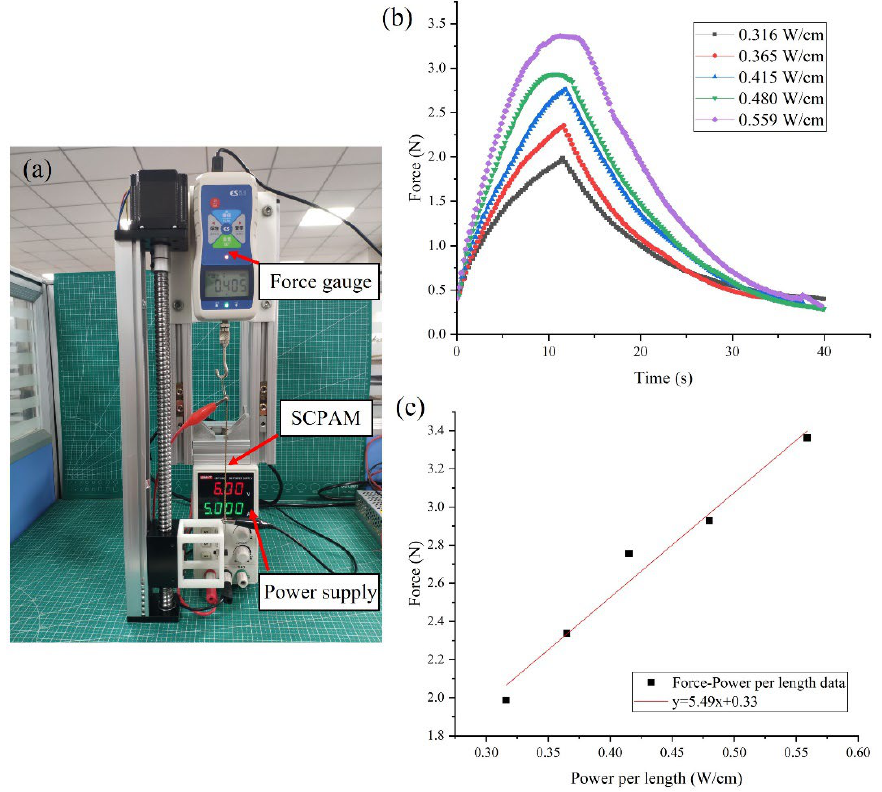
Figure 5. Force characterization of SCPAM. ( a ) Test platform. ( b ) Force–time curves under different power per length conditions. ( c ) Relationship between the maximum output force and power per length.